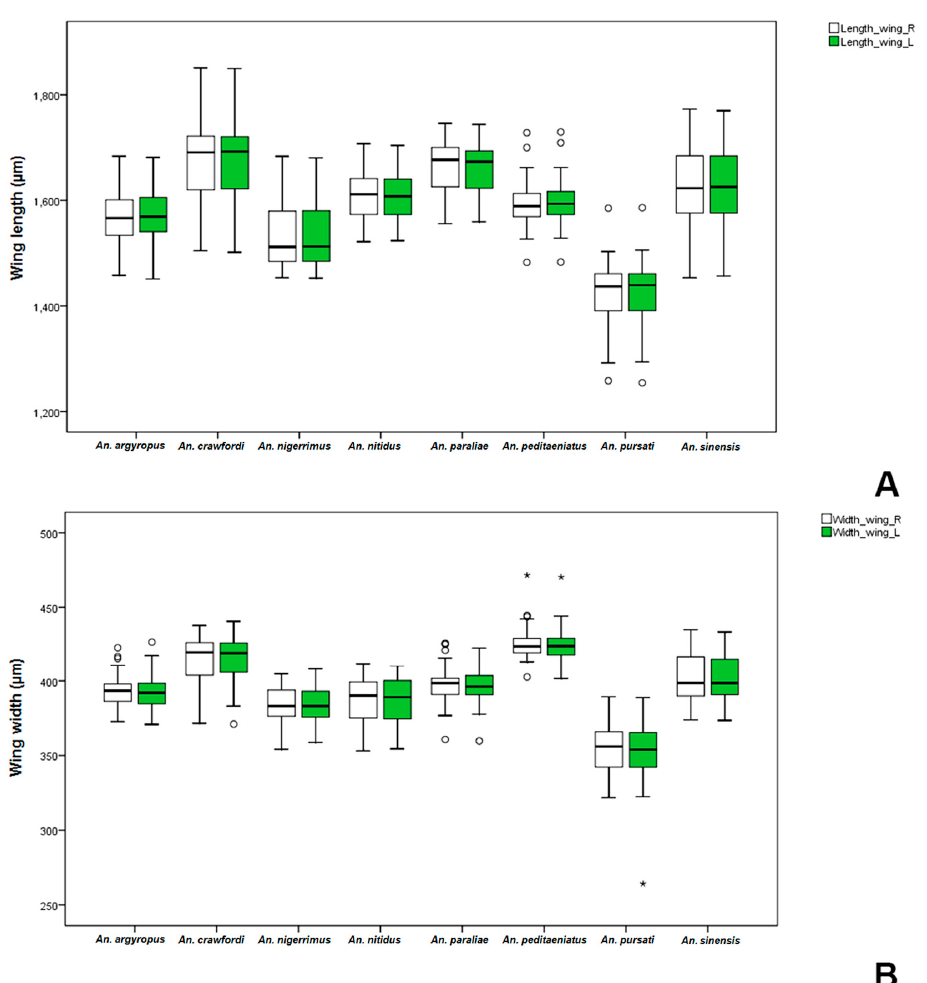
Figure 5. The Box-and-Whisker Plots representation of variation in wing length ( A ) and width ( B ) of adult male of the eight Hyrcanus Group species.